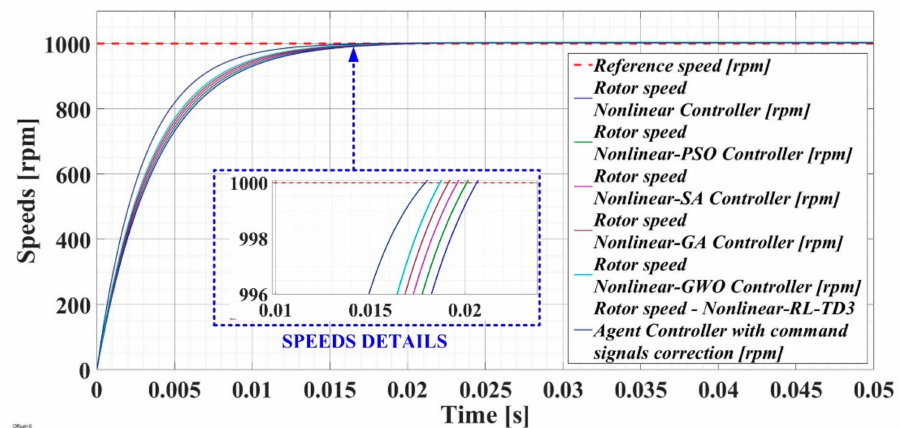
Figure 19. Comparison of the time evolution of speed for PMSM–CS–CI based on the nonlinear- type